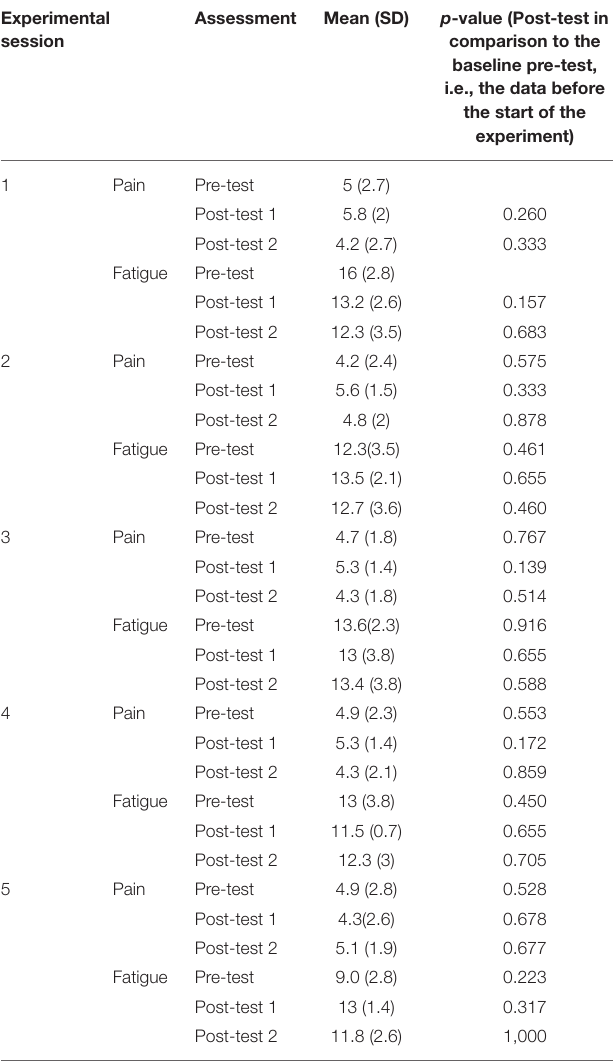
TABLE 2 | Pain and fatigue